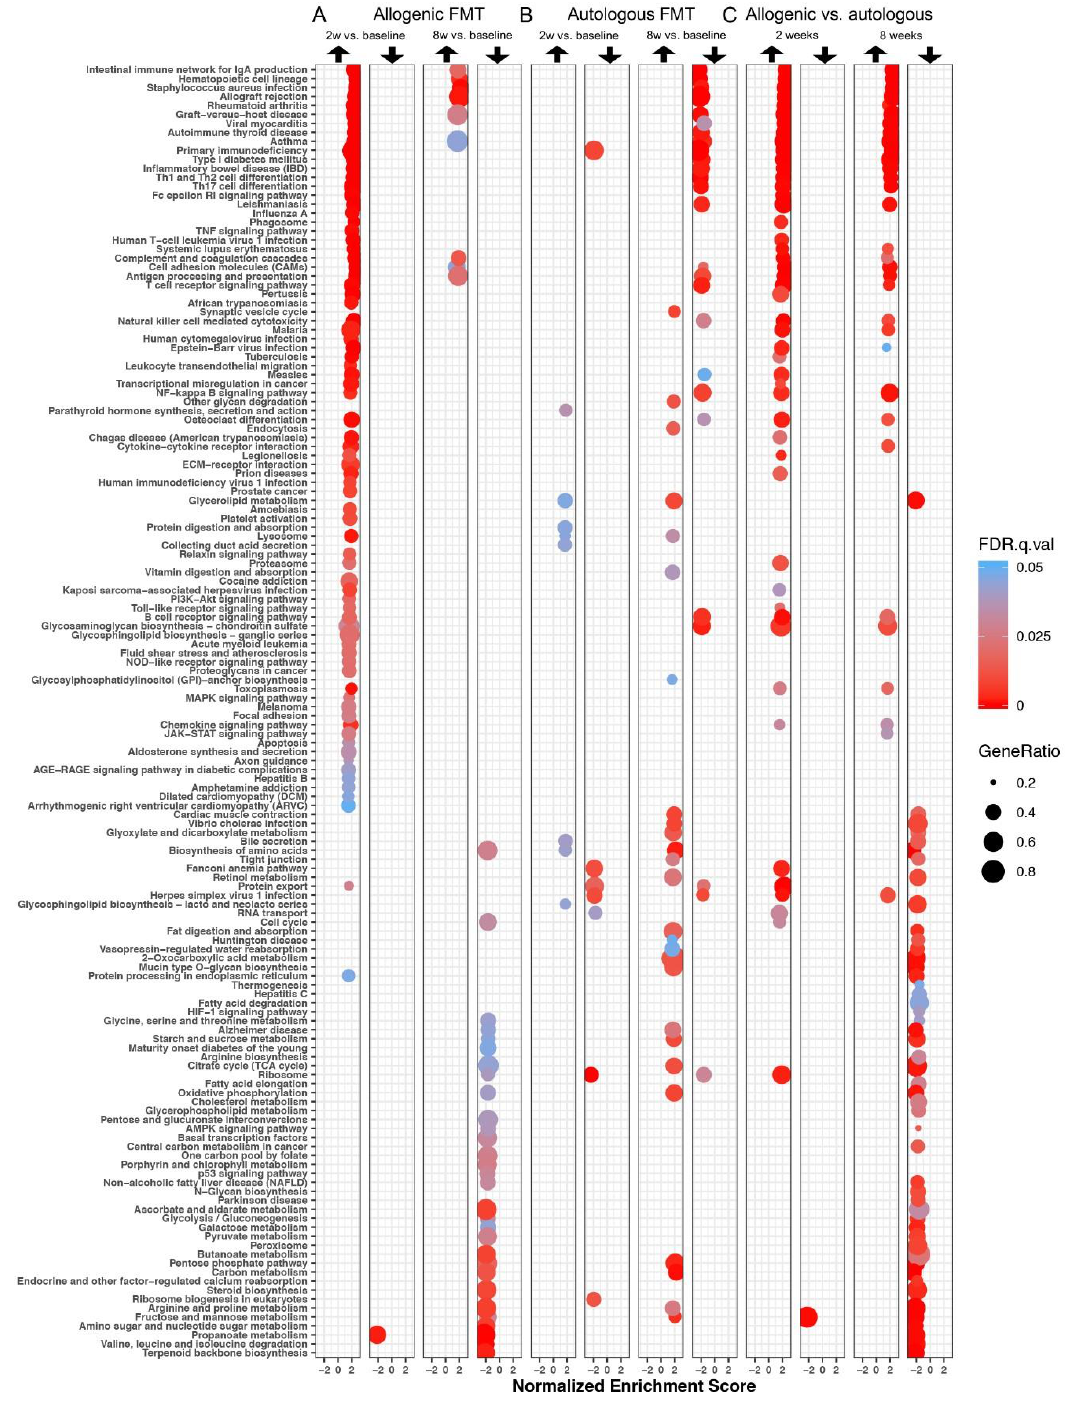
Figure 1. Differentially expressed gene sets after faecal microbiota transfer (FMT). ( A ) Allogenic FMT (within-group comparisons). ( B ) Autologous FMT (within-group comparisons). ( C ) Allogenic versus autologous FMT (two and eight weeks after FMT, baseline-corrected). Gene set enrichment analysis (GSEA) was performed. Each row depicts a gene set that was significantly differentially regulated in one of the six comparisons (false discovery rate, FDR < 0.05), with the corresponding normalised enrichment score (NES) value on the y -axis. The colour of the dot indicates the statistically significant FDR value of the corresponding gene set in that specific comparison. The size of the dot reflects the gene ratio, which represents the number of enriched genes in the gene set.